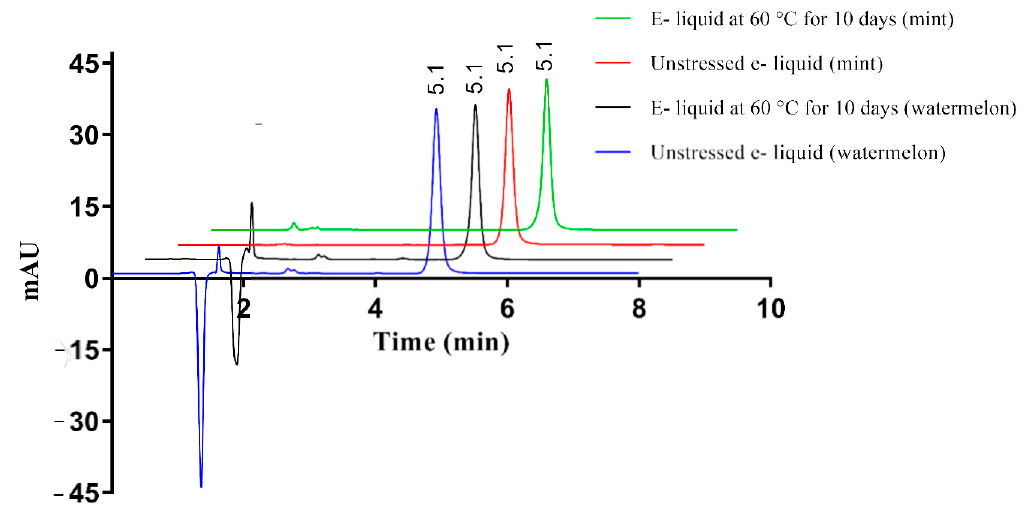
Figure 4. Chromatograms of e-liquids in standard and thermally stressed conditions (30 µ g/mL). The nicotine peak is seen eluting after 5 min in all the conditions. −